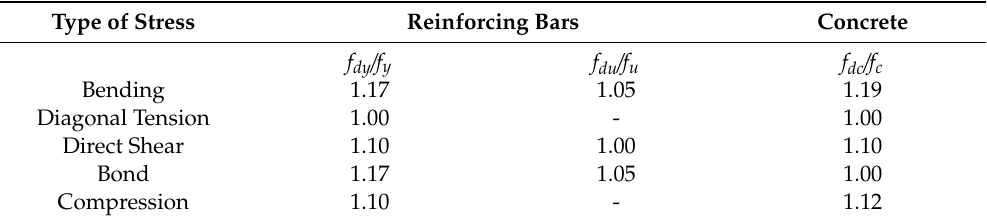
Table 3. Dynamic increase factor (DIF) for RC elements, extracted from [25].